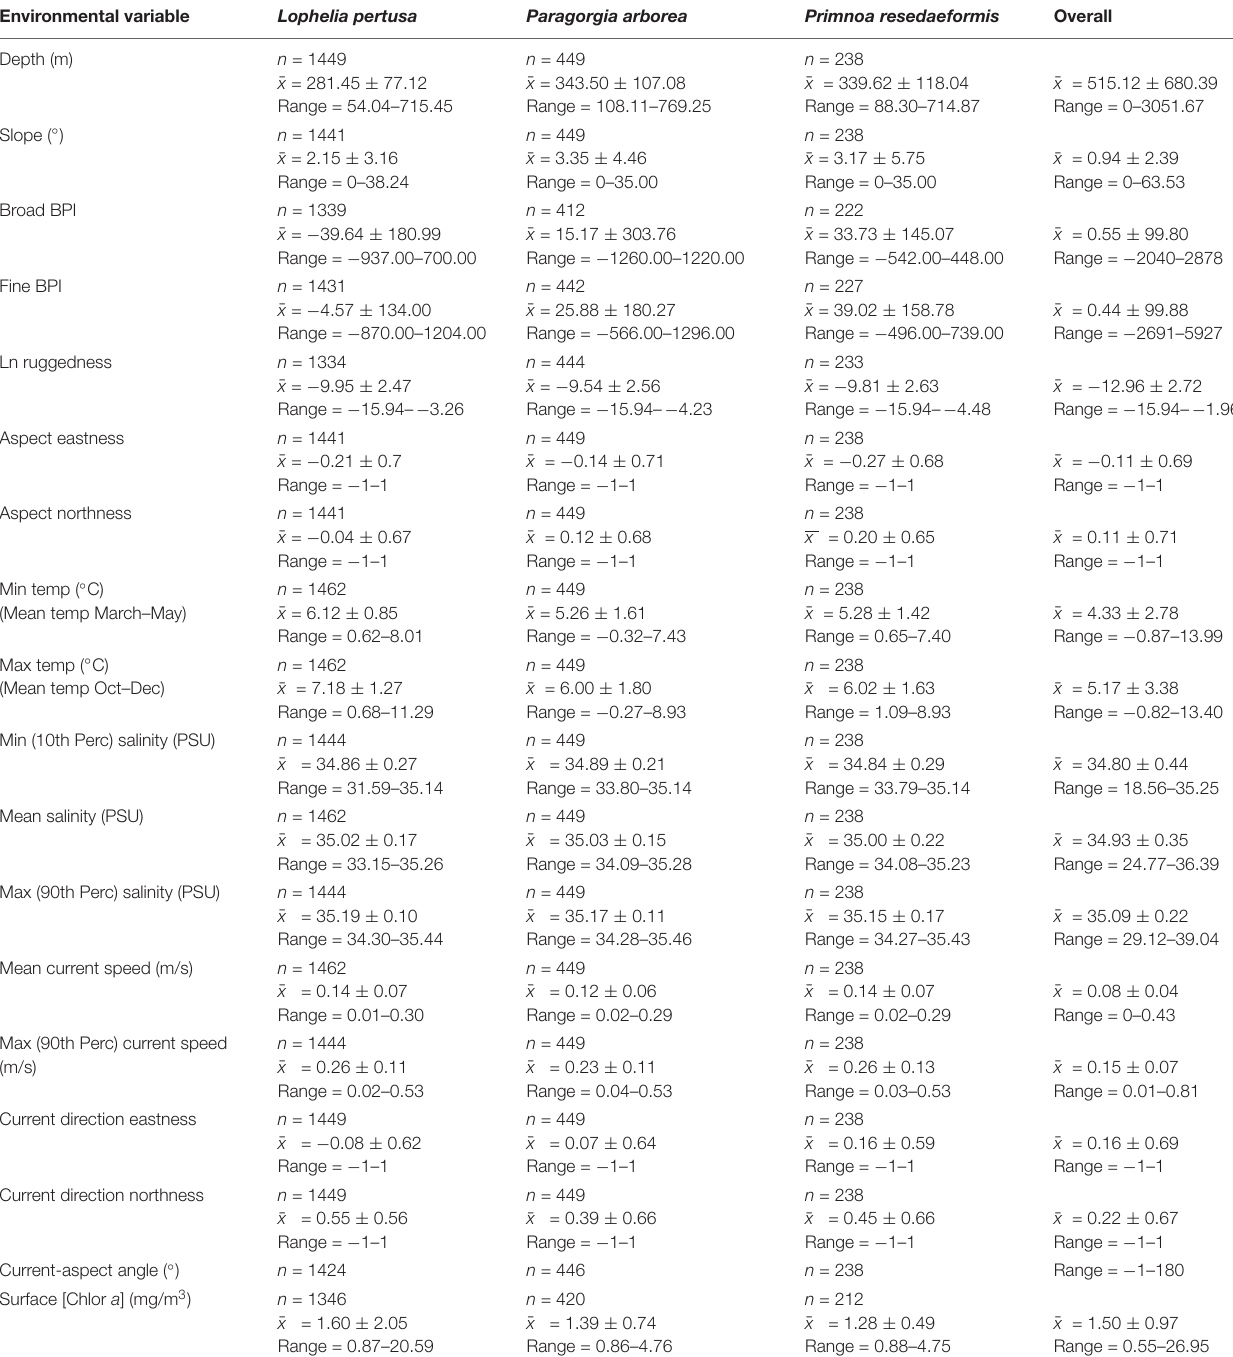
TABLE 3 | Summary statistics count (n), mean ( ¯ x ) ± standard deviation (s), and range (min to max) for the continuous environmental variables for each species and the overall study